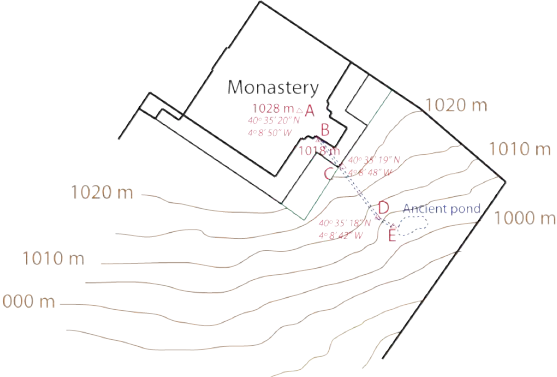
Figure 9. Map of the South-east area of the Monastery, showing the different sections of the drainage tunnel. The water tower is located in